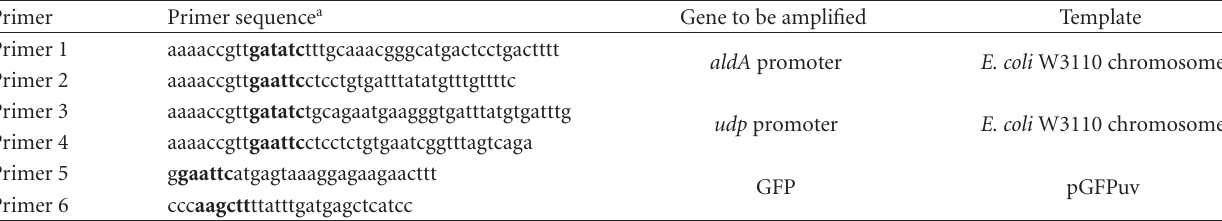
Table 2: List of primers used in PCR